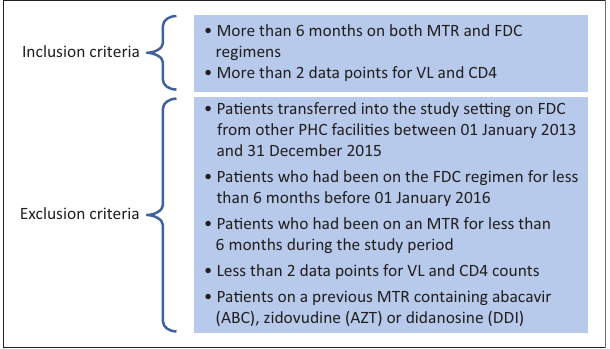
FIGURE 2: Inclusion and exclusion